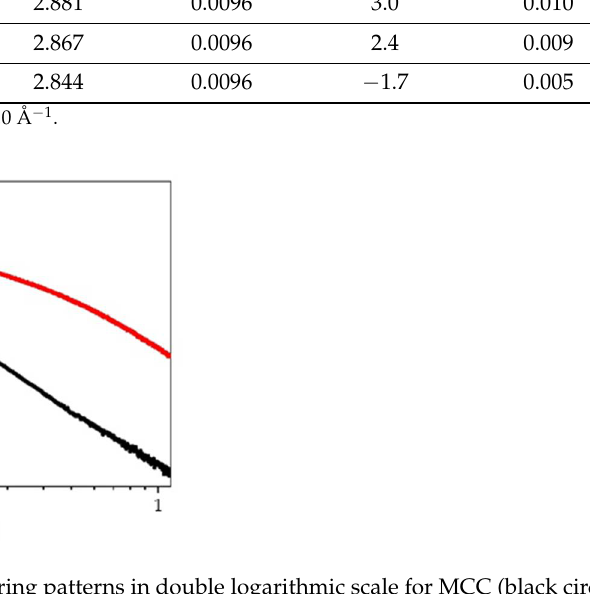
Figure 10. Small-angle X-ray scattering patterns in double logarithmic scale for MCC (black circles) and AC (red triangles).